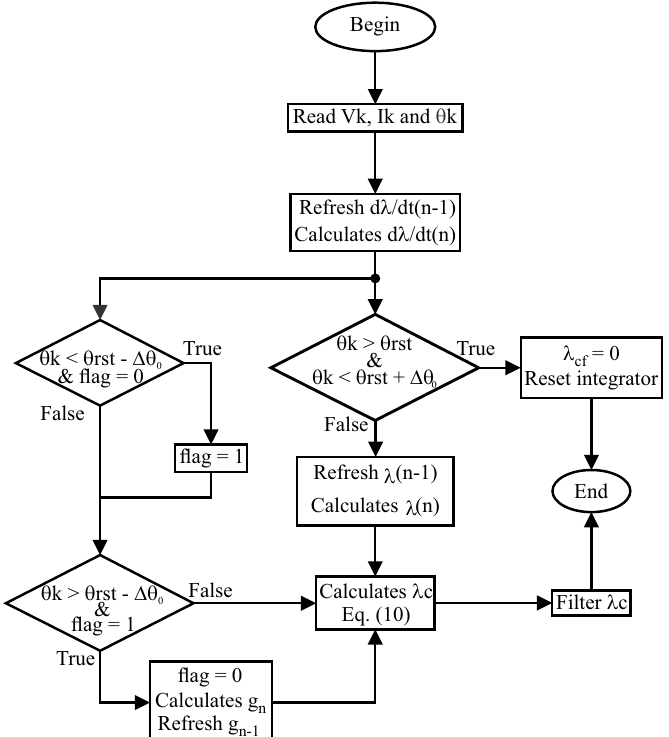
Figure 9. Flow chart for the implementation of the proposed drift cancellation